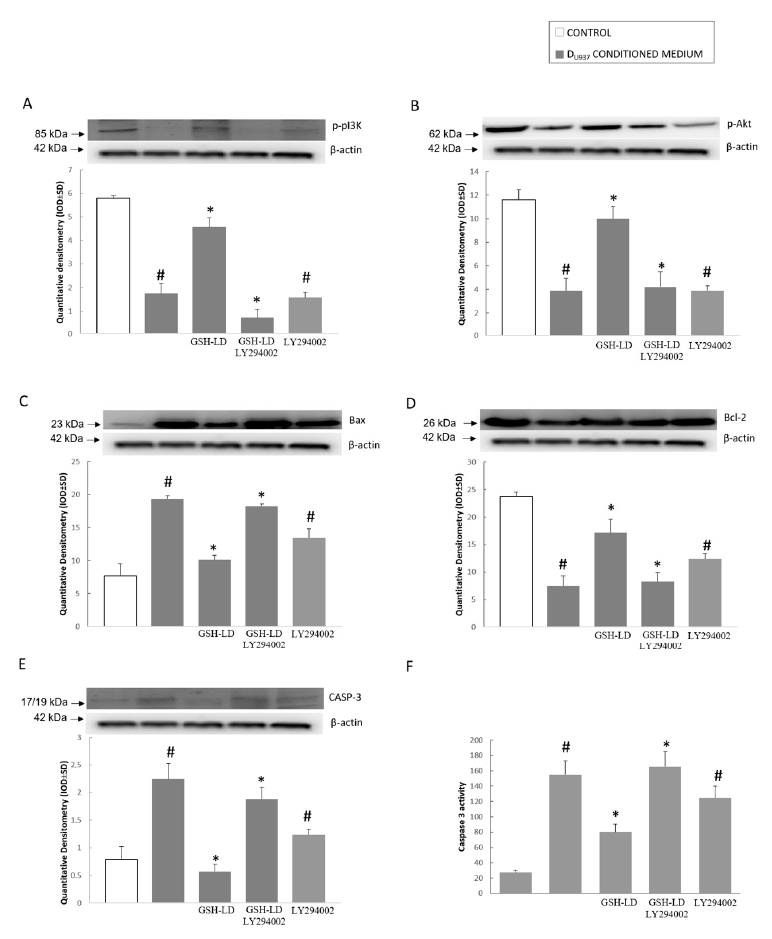
Figure 8. E ff ect of GSH-LD on phosphinositide 3-kinase / kinase B (PI3K / Akt) pathway in D SH-Sy5Y Figure 8. Effect of GSH-LD on phosphinositide 3-kinase/kinase B (PI3K/Akt) pathway in D SH-Sy5Y cells treated with D U937 cells conditioned medium. D SH-Sy5Y cells were preincubated with GSH-LD (1 μ M) for 1 h, followed by treatment with D U937 cells conditioned medium. Representative image of Western blot experiments (top) and data analysis (bottom) showing expression of ( A ) p-PI3k; ( B ) p-Akt; ( C ) Bax; ( D ) Bcl-2; ( E ) Caspase 3 on total protein extracts of SH-SY5Y cell. Caspase 3 activity ( F ) was examined using the fluorogenic substrate Ac(N-acetyl)-DEVD-AMC (7-amino-4-methylcoumarin). LY294002 (a selective PI3K inhibitor) was used to evaluate the effect on the expression of related proteins in D SH-Sy5Y cells after GSH-LD treatment. ß-actin was used as internal standard. The data are expressed as the mean ± SD of three independent experiments. # p < 0.05 vs CTRL; * p < 0.05 vs cells treated with conditioned medium. 4. Discussion